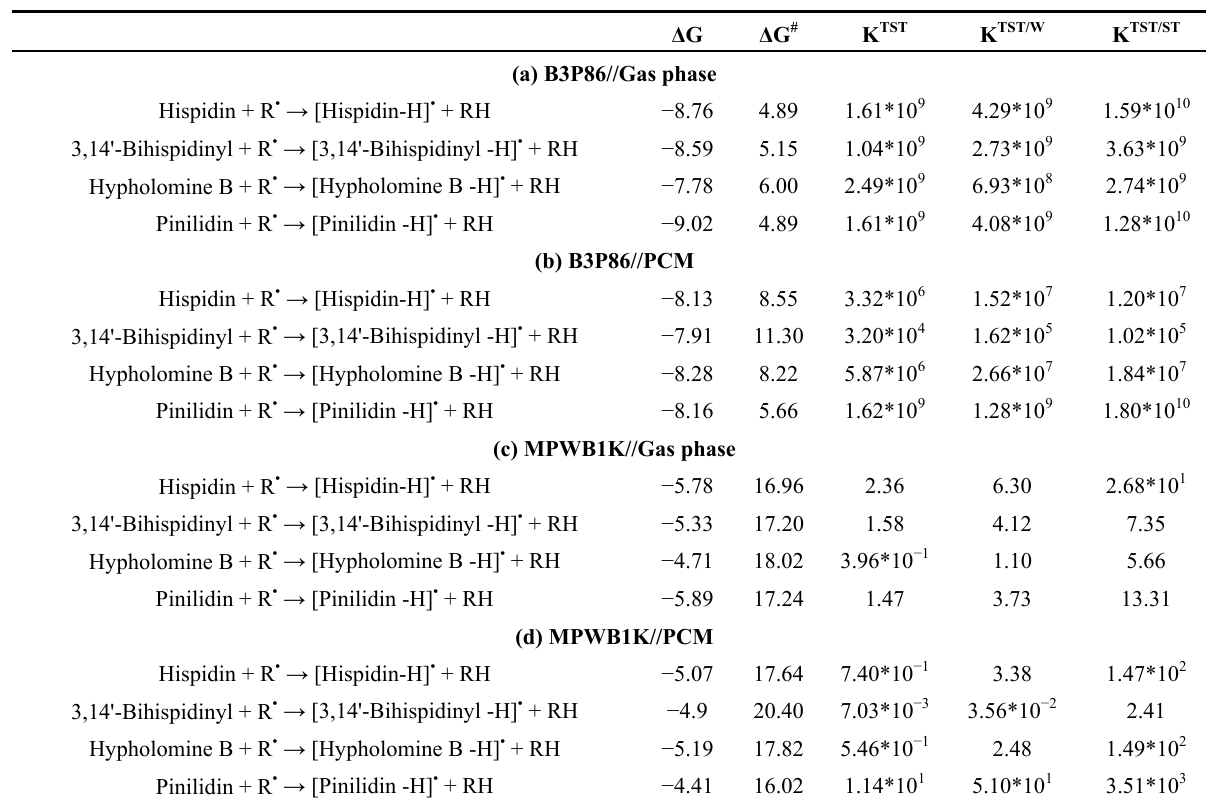
Table 5. Calculated thermodynamics ( Δ G in kcal/mol) and kinetics ( Δ G # in kcal/mol and K in M − 1 ·s − 1 ) parameters of PC-ET mechanism of the CH3OO • (R • ) free radical scavenging by